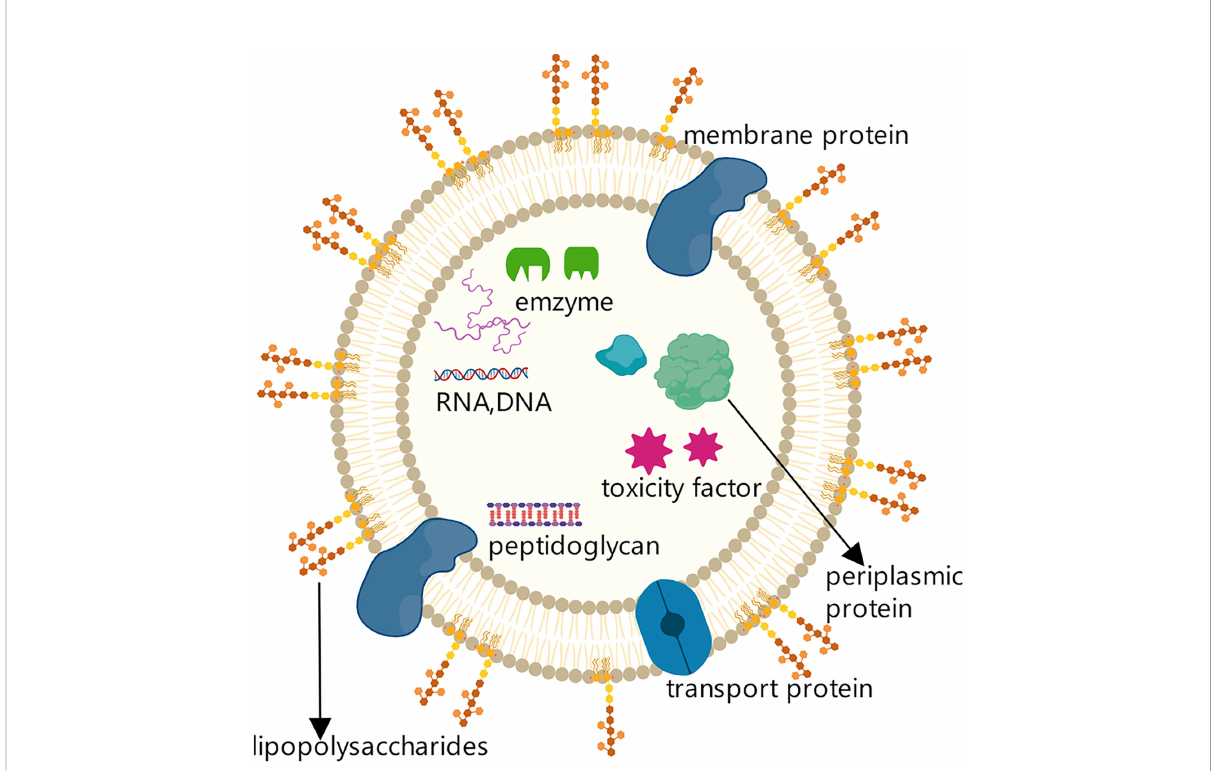
FIGURE 1 Structure and components of OMVs secreted by Gram-negative bacteria. Structure and components of OMVs secreted by Gram-negative bacteria. OMVs secreted by Gram-negative bacteria are lipid-based spherical vesicles that feature lipopolysaccharides (LPS), membrane proteins, transporters, and other substances on the membrane